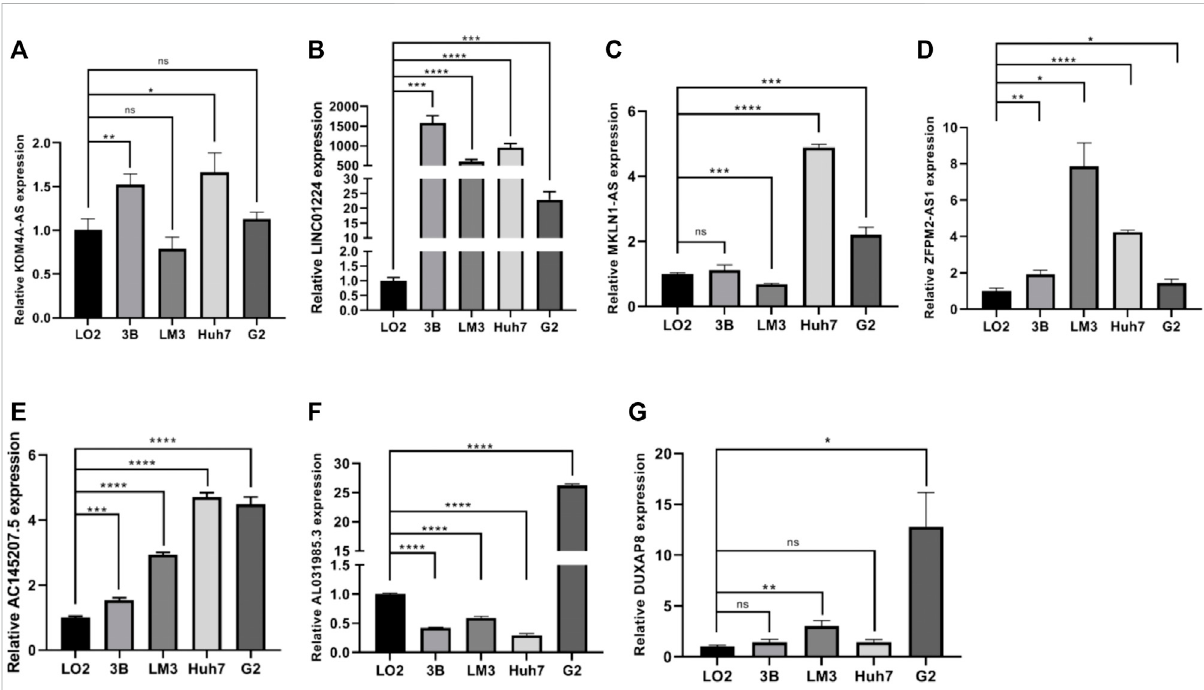
FIGURE 11 (A – G) The expression differences of KDM4A-AS1, LINC01224, MKLN1-AS, ZFPM2-AS1, AC145207.5, AL031985.3, and DUXAP8 in normal liver tissue and HCC